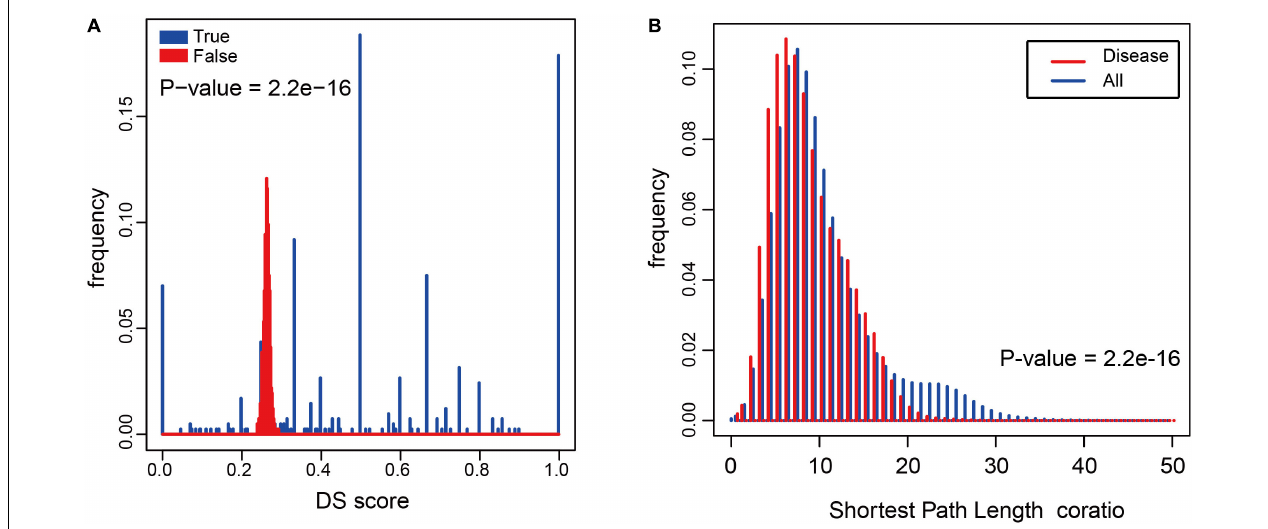
FIGURE 4 | The relationship between diseases and metabolites in the HDMN. (A) Comparison of true DS score with random disturbance DS score ( P -value = 2.2e-16, two sided Wilcox. Test). (B) The shortest distances between any two nodes in the metabolic network, and the shortest distance between disease metabolites ( P -value = 2.2e-16, two sided Wilcox.